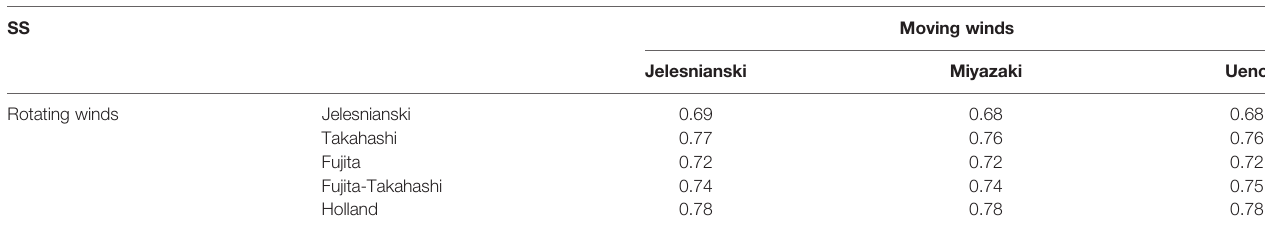
TABLE 2 | SS values of different wind models.